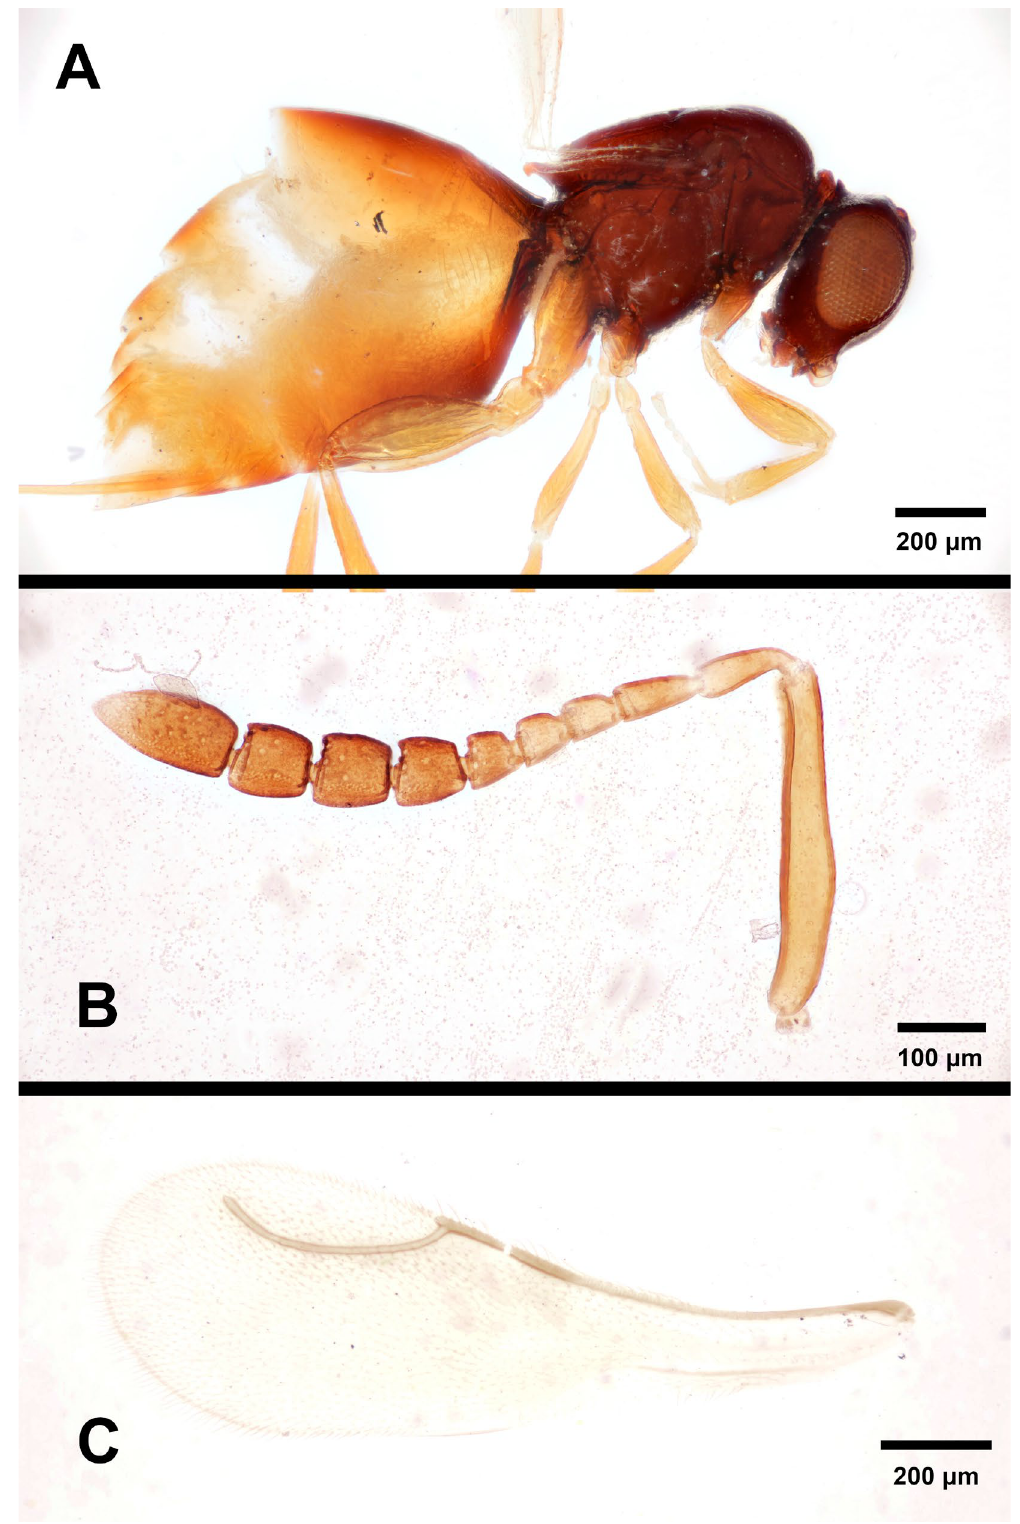
Fig. 13. Ceraphron naivashae kieffer, 1913, holotype, ♀. A . Lateral view (MNhN EY25360). B . Left antenna (MNhN EY22430). C. Left wing (MNhN